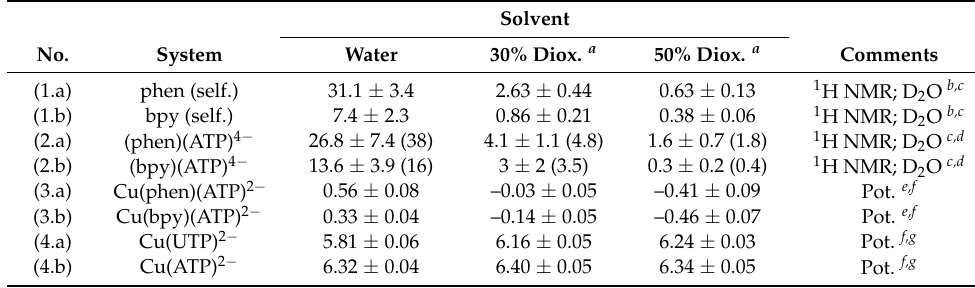
Table 10. Effect of 1,4-dioxane ( v/v ) on the stability of stacks formed in various systems and various solvents a